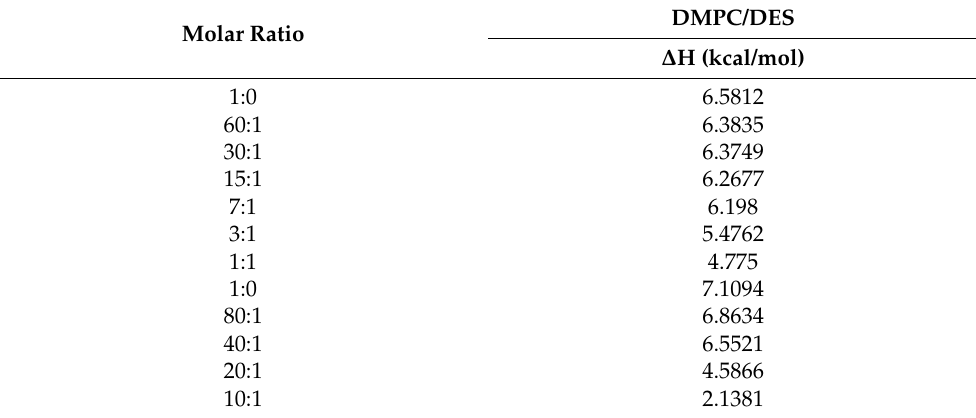
Table 1. Changes in ∆ H after the addition of DES to membranes of DMPC and DEPE (1,2-dielaidoyl- sn